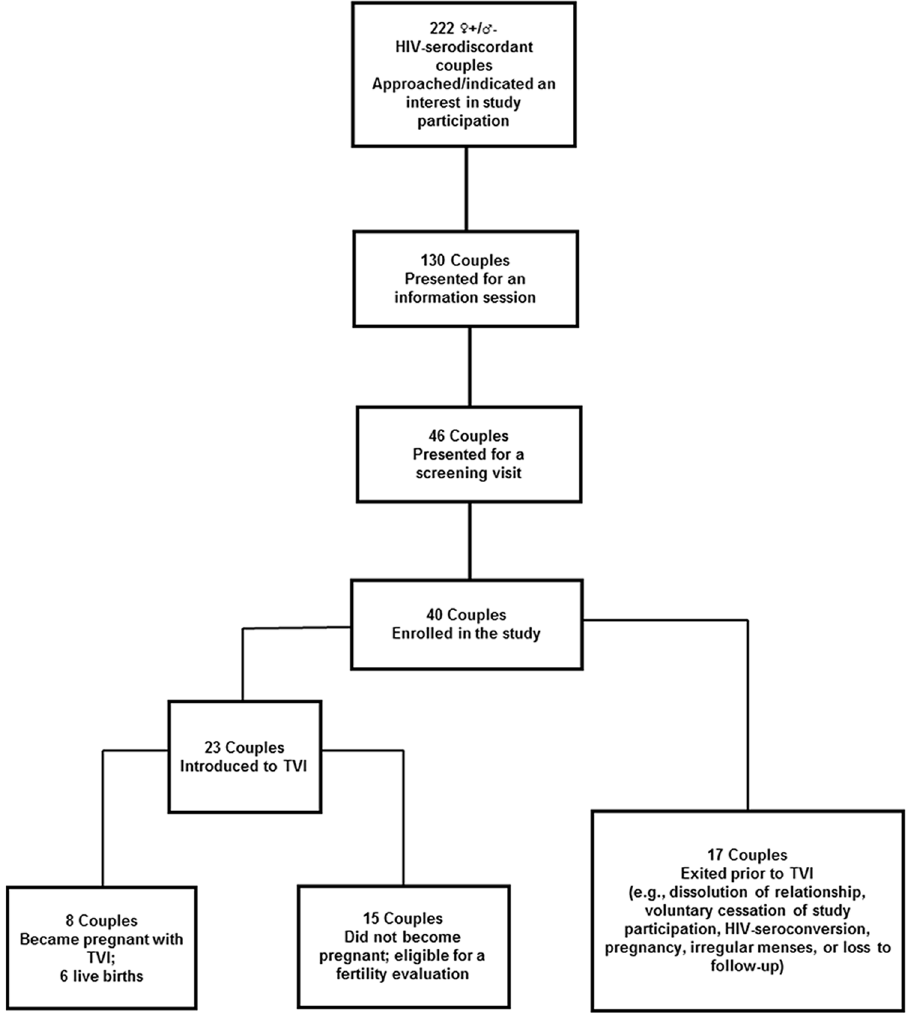
Fig 1. Study participants. ♀ +/ ♂ - Female positive/male